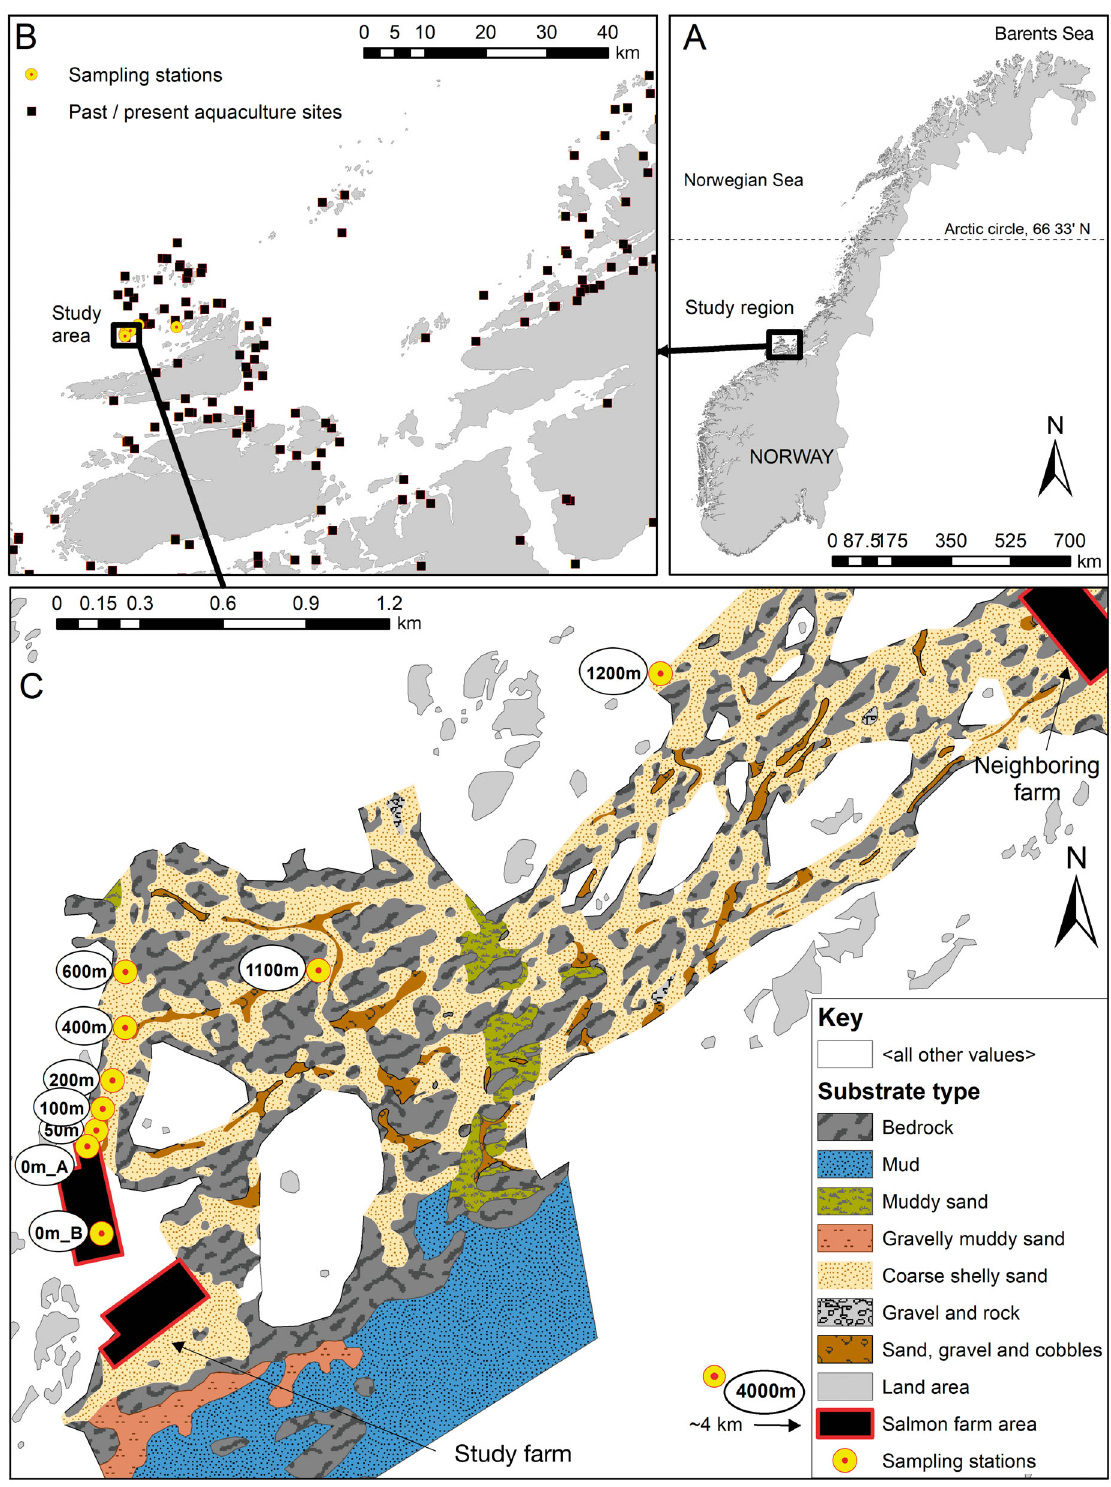
Fig. 1. (A) Location of the Frøya region on the west coast of Norway. (B) Study farm location within the Frøya Island network and locations of past/present salmon farms. (C) Location of the farm in relation to the mixed-substrate seabed (modified from Plassen et al. 2014) and indicating the position of the main transect and the 1100, 1200 and 4000 m sampling stations (station distances pertain to distances from the nearest